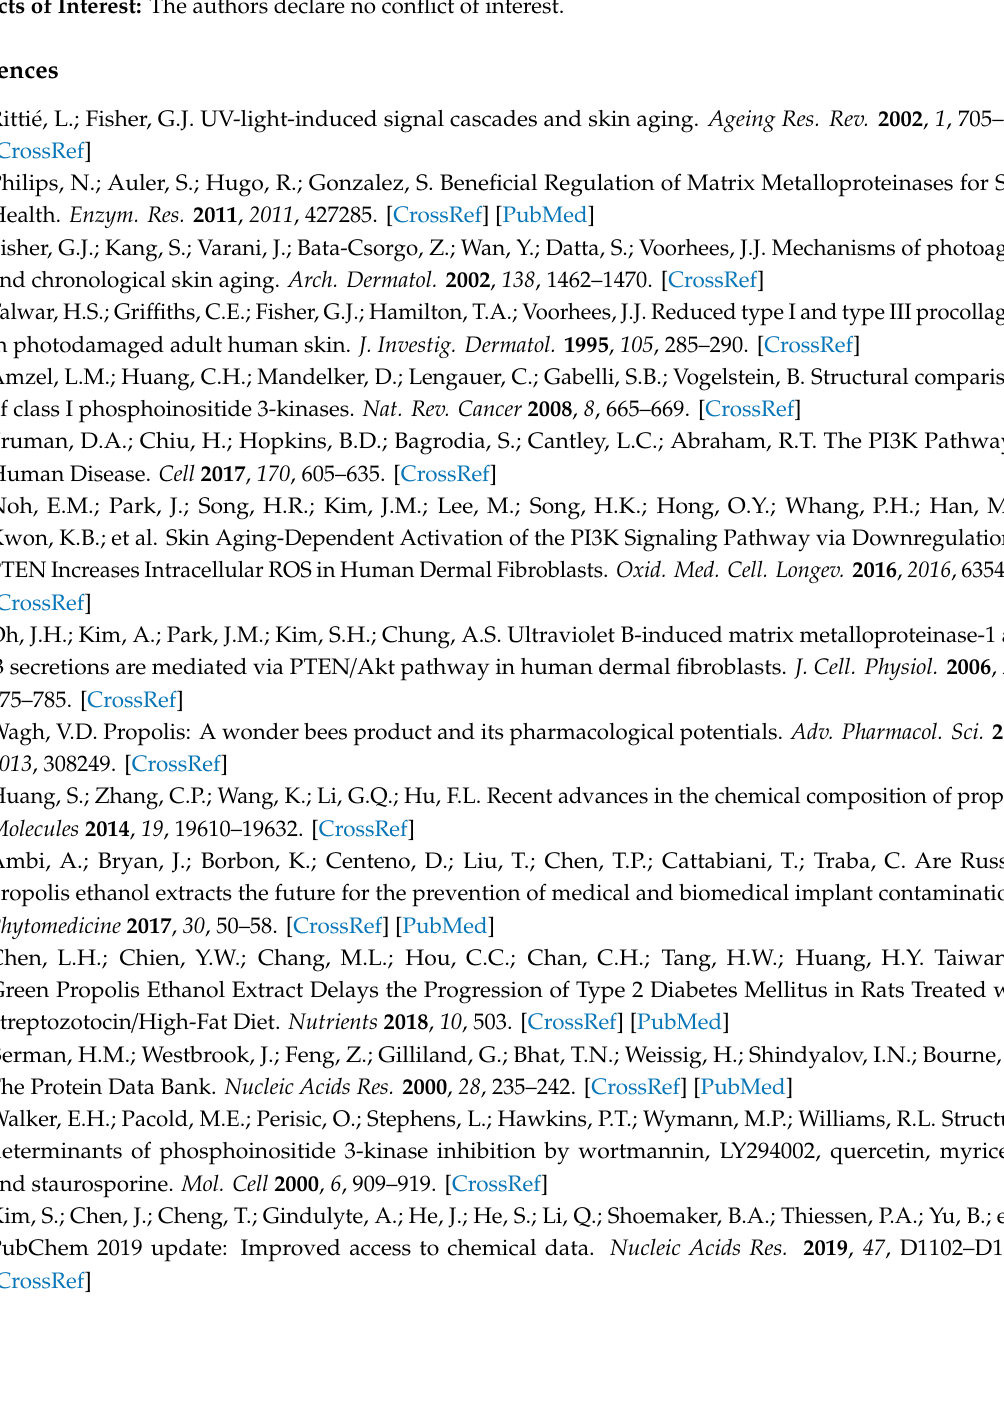
Figure S1: Distribution of binding